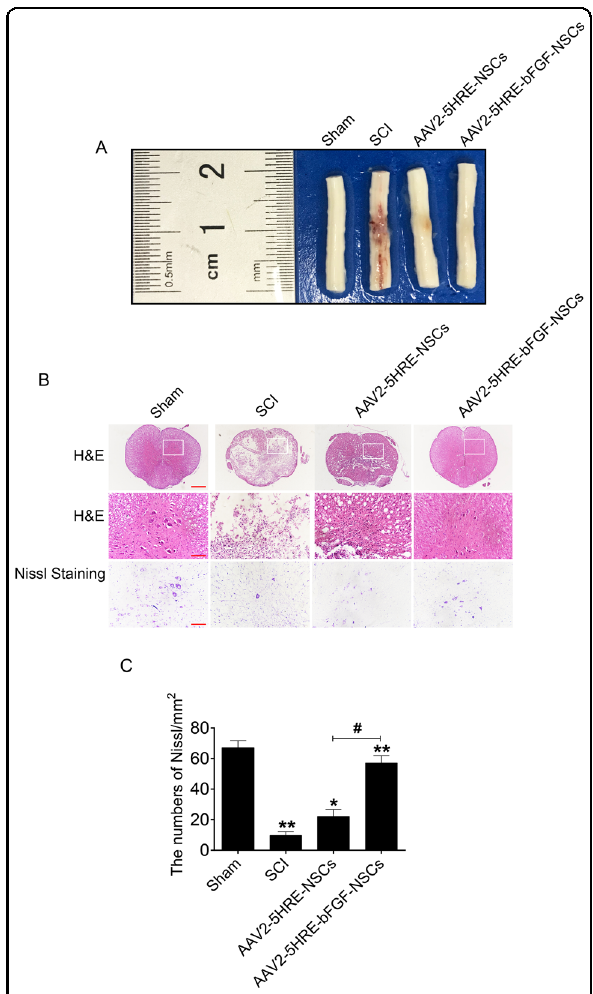
Fig. 3 AAV2-5HRE-bFGF-NSCs improve the histopathology in SCI rats. A Anatomical observation of the spinal cord of rats. B H&E staining (cross-section) and nissel staining images for the sham group, SCI group, AAV2-5HRE-NSCs group and AAV2-5HRE-bFGF-NSCs group, scale bar = 500 µm. Representative regions with high power magni fi cation were also presented, scale bar = 100 µm. Nissl staining of the different groups, scale bar = 100 µm. C Quantitative analysis of the nissl staining results. “ ** ” represents P < 0.01 or “ * ” represents P < 0.05, versus sham group or SCI group. “ # ” represents P < 0.05, versus the AAV2-5HRE-NSCs group. Data are the mean values ± SEM ( n =